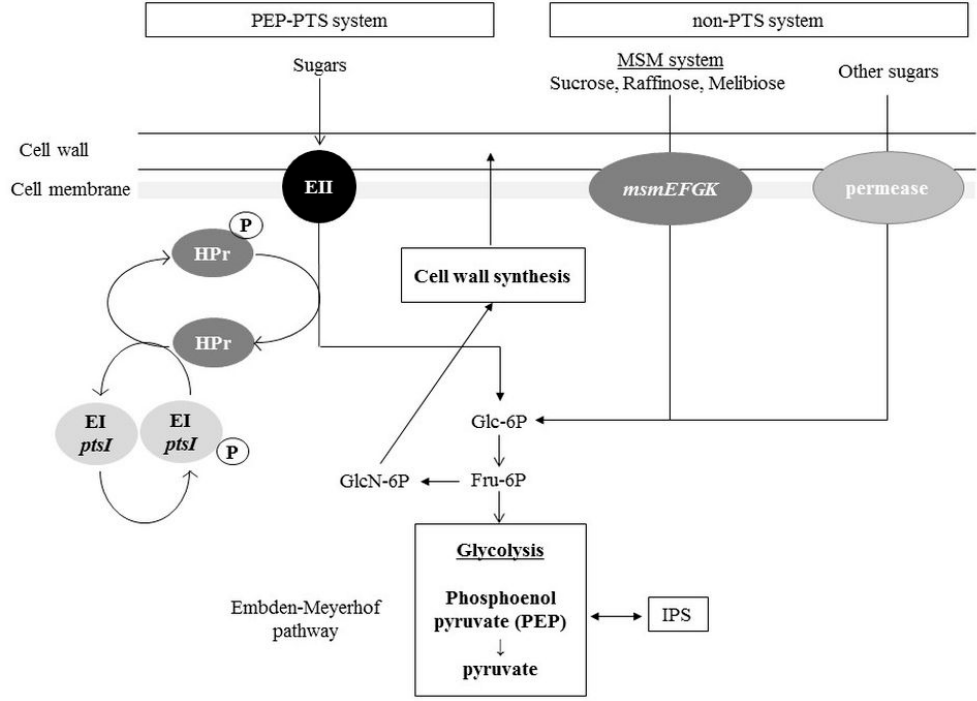
Figure 2. Phosphotransferase (PTS) and non ‐ PTS system in S. mutans . Bacteria can take